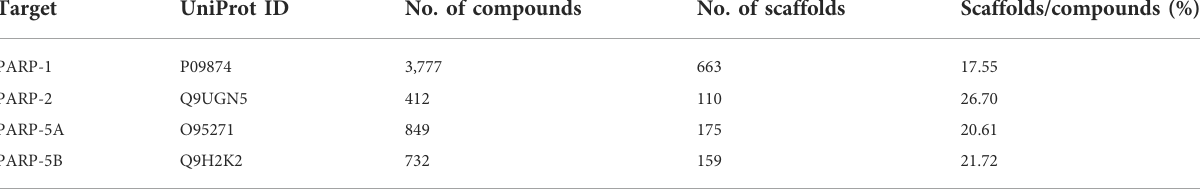
TABLE 1 The modelling datasets of PARPs